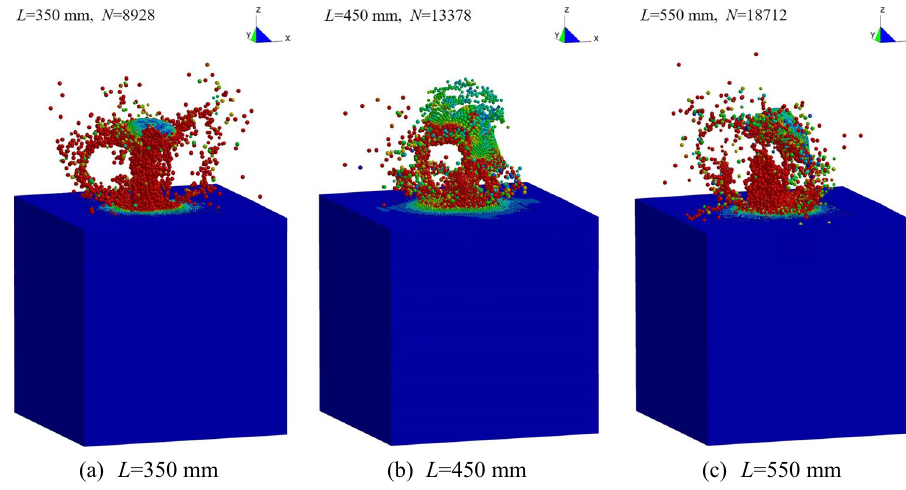
Fig. 16 Different cutting hole spacing. a L = 350 mm; b L = 450 mm; c L = 550